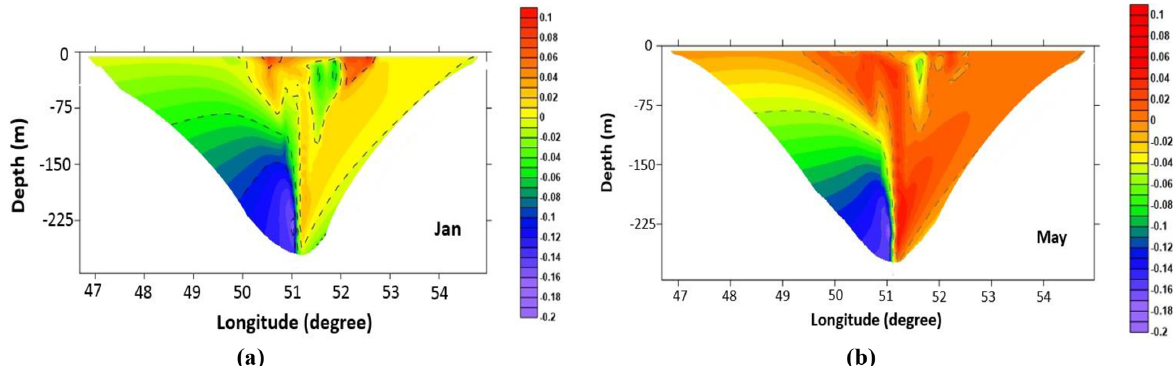
Figure 6. Cross section of the mean velocity (ms − 1 ) in transect I, obtained from model simulations, (a) for January and (b) May. This deep flow is moving